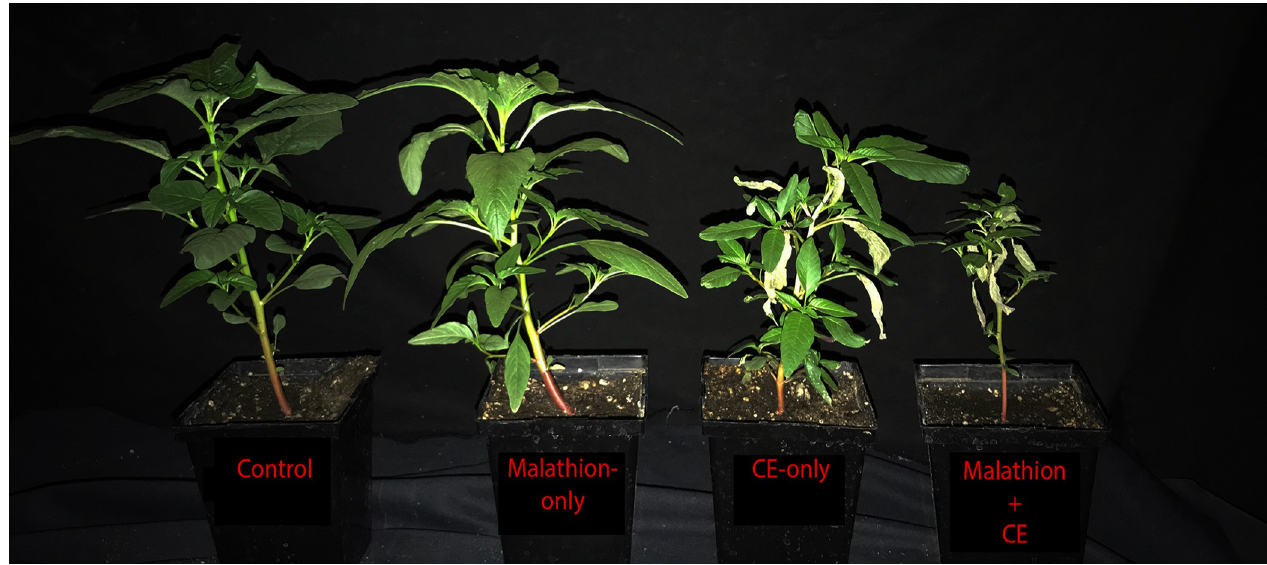
Fig 4. SIR plants 10 days after treatments with carfentrazone-ethyl (CE) and malathion applied alone and in combinaton. Plants at a height of 9–11 cm were treated with either adjuvants only (control), 2000 g ai ha -1 malathion (one hour before CE) plus a 5 mM malathion solution soil drench (50 mL pot -1 ) two days later, 14 g ai ha -1 CE, or malathion plus CE with the corresponding adjuvants described in Methods. Pictures of injury were taken and aboveground biomass was harvested at 10 DAT to determine dry weight accumulations per treatment. Two independent experiments were conducted with five replications each. Combined means for each treatment (expressed as a percentage of the adjuvant-only control) were 90.8% for malathion-only, 36.5% for CE-only, and 15.2% for the combination of malathion plus CE. A Fisher’s protected LSD value of 13.0 ( α = 0.05) was used to determine significant differences among